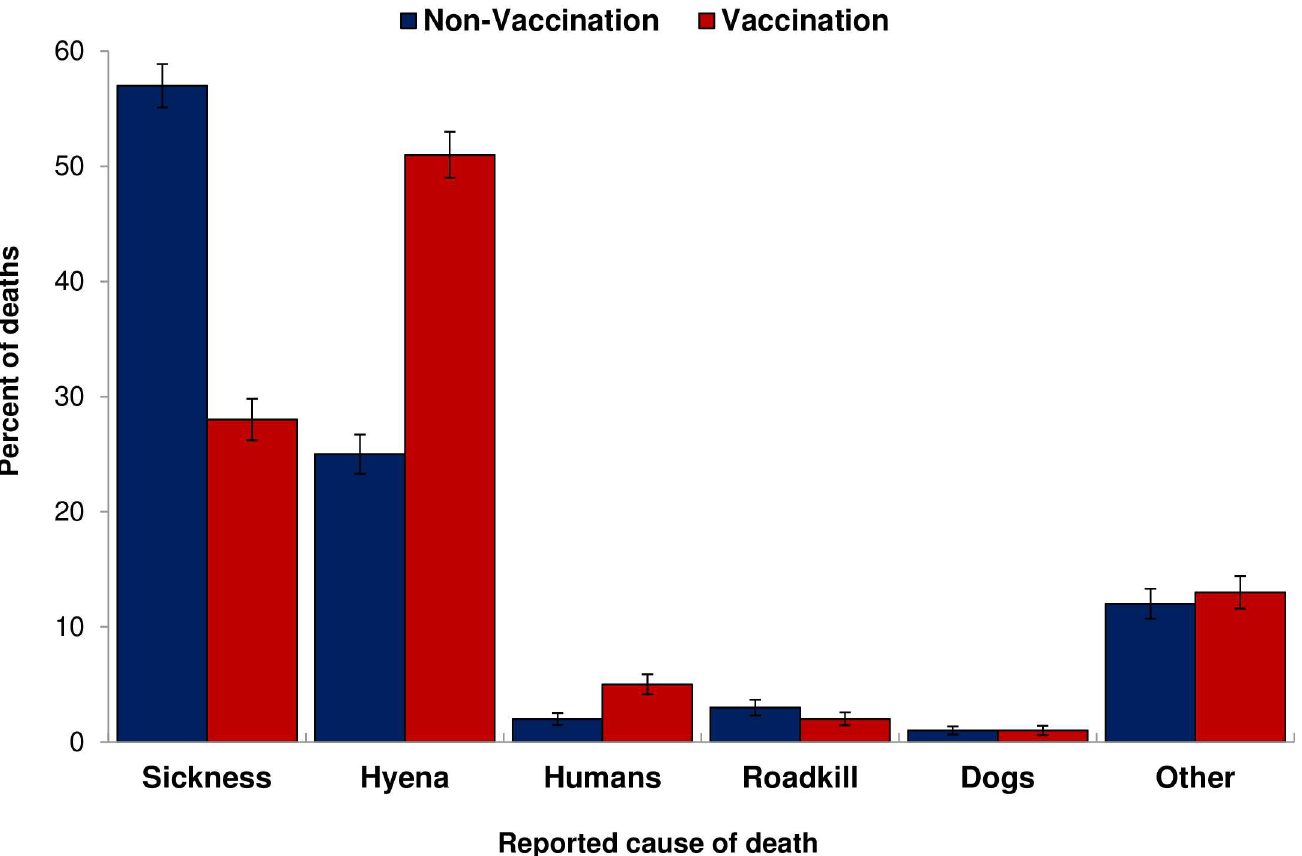
Fig 7. Percentage of owner-reported causes of death of dogs enrolled in the study. Blue bars represent non-vaccination villages(Buyubi and Iyogelo). Red bars representvaccinationvillages(Nangaleand Sanungu).Error bars represent 95%